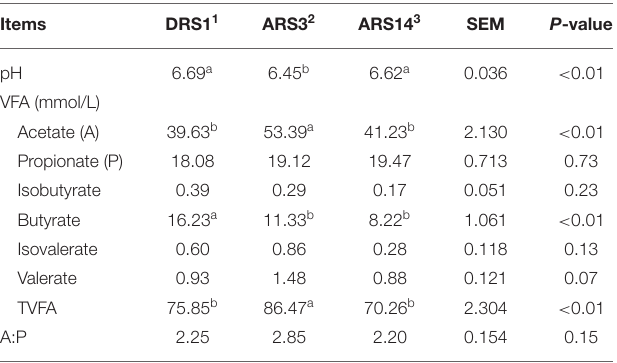
TABLE 2 | The fermentation parameters of rumen fluid after fistula surgery in sheep.